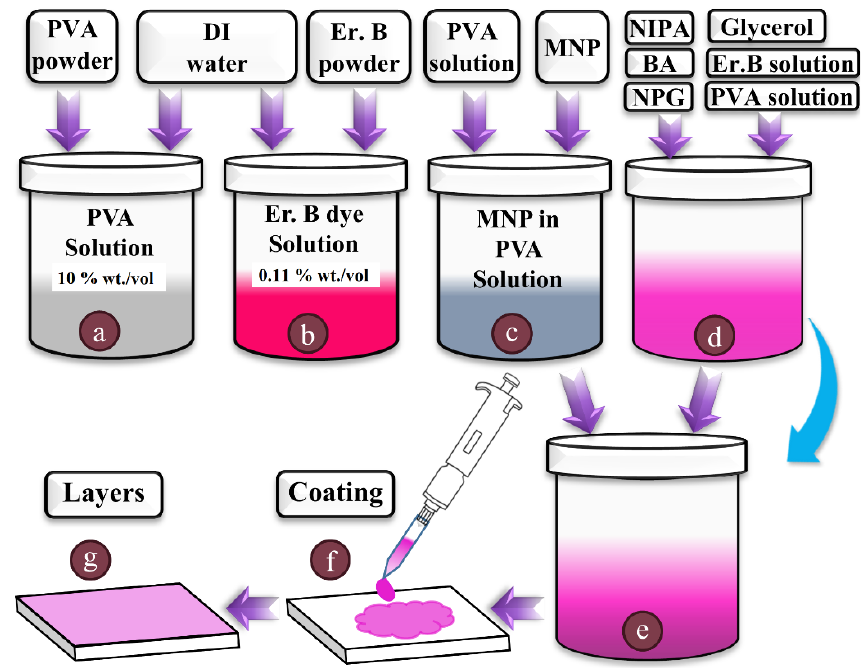
Figure 2. Preparation of the liquid samples and nanocomposite layers. ( a ) PVA solution, ( b ) Er. B dye, ( c ) MNP are dispersed in PVA solution, ( d ) pure NIPA-based polymer, ( e ) photopolymer nanocomposite achieved by mixing materials from step-c and step-d, ( f ) coating of nanocomposite solution, ( g ) finally prepared nanocomposite layer.